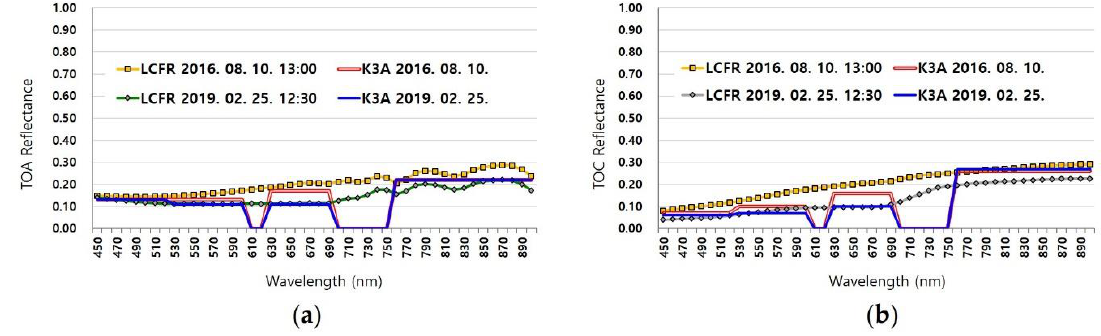
Figure 4. Comparison between the data from the RadCalNet LCFR site and the KOMPSAT-3A reflectance products: ( a ) TOA ( b ) TOC reflectance products for 10 August 2016 and 25 February 2019. Table 3. KOMPSAT-3A TOA and TOC reflectance products and data from the RadCalNet LCFR site